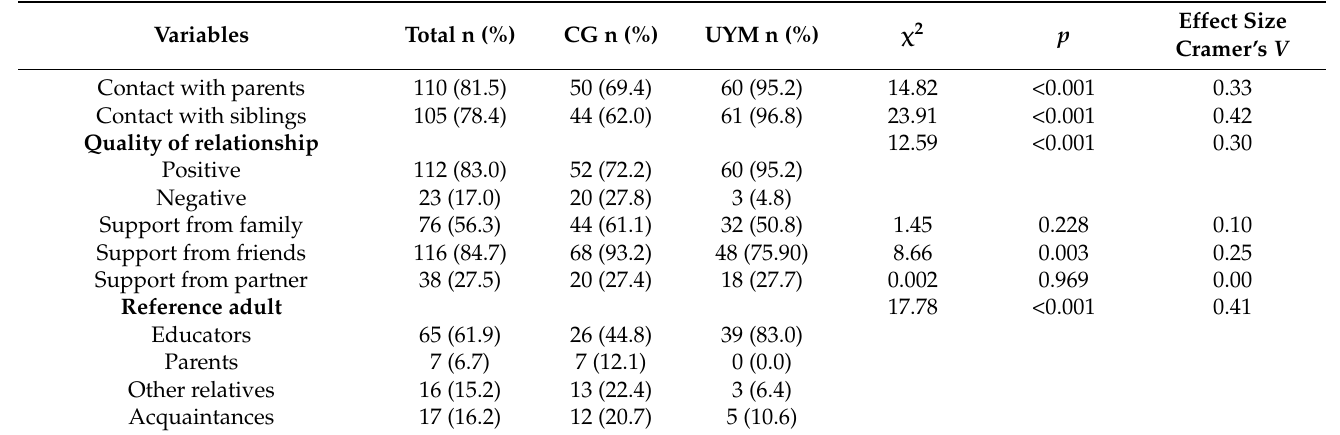
Table 4. Support Network. Differences between groups.